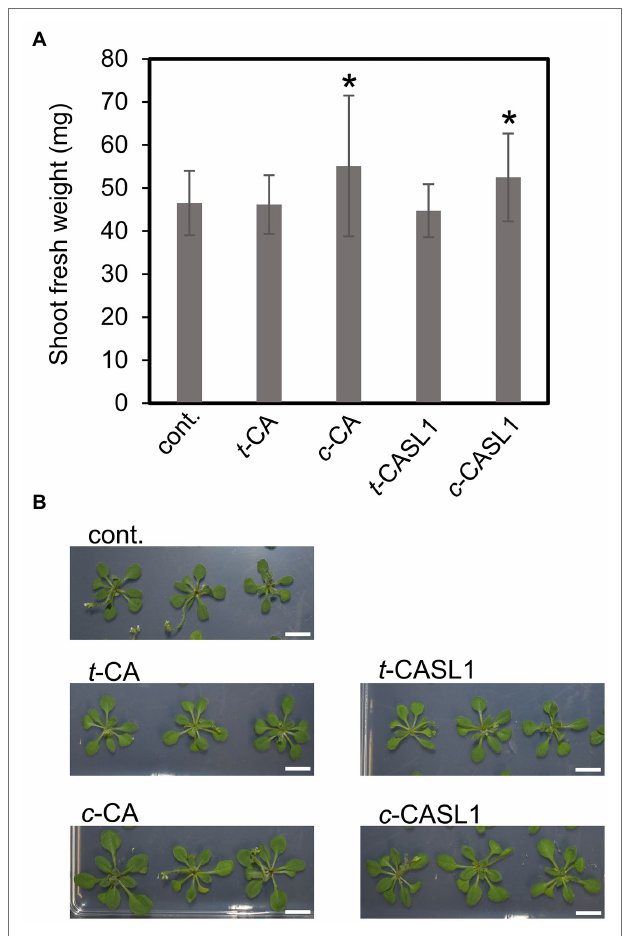
FIGURE 7 | Effects of the CAs and CASLs on the Arabidosis seedling growth. (A) Fresh weight of the shoot parts after growing for 20 days on agar plate containing 1 μ M test compounds. Data are the means ± SD ( n = 13–25). Asterisk indicate the significant differences between the control using t -test (* p < 0.05). (B) Shoot phenotype of 20-days old seedling which were grown on the agar medium containing the indicated compounds (Scale bar = 1 cm). cont. means control with only acetone at